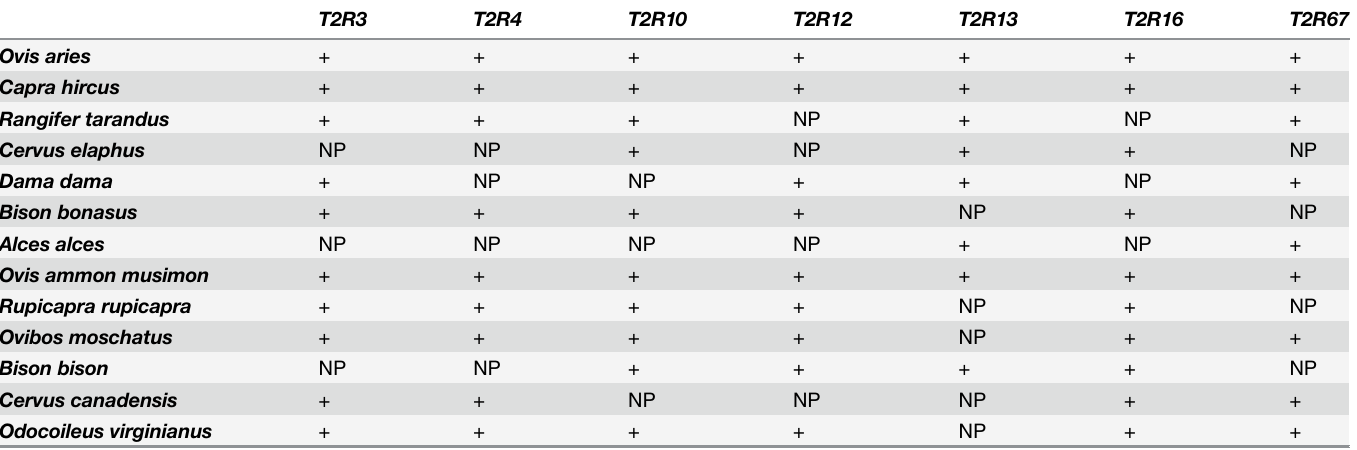
Table 2. Screening of T2R